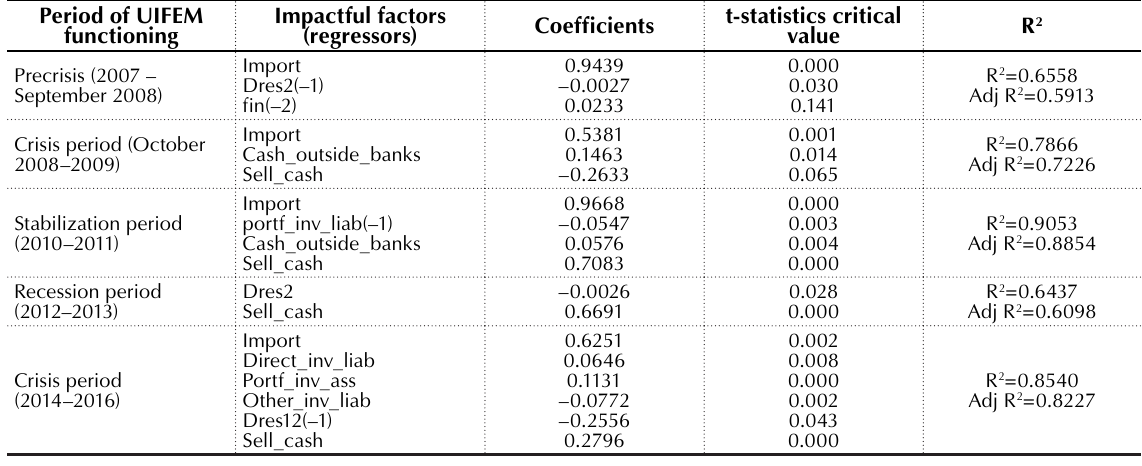
Source: estimated by the